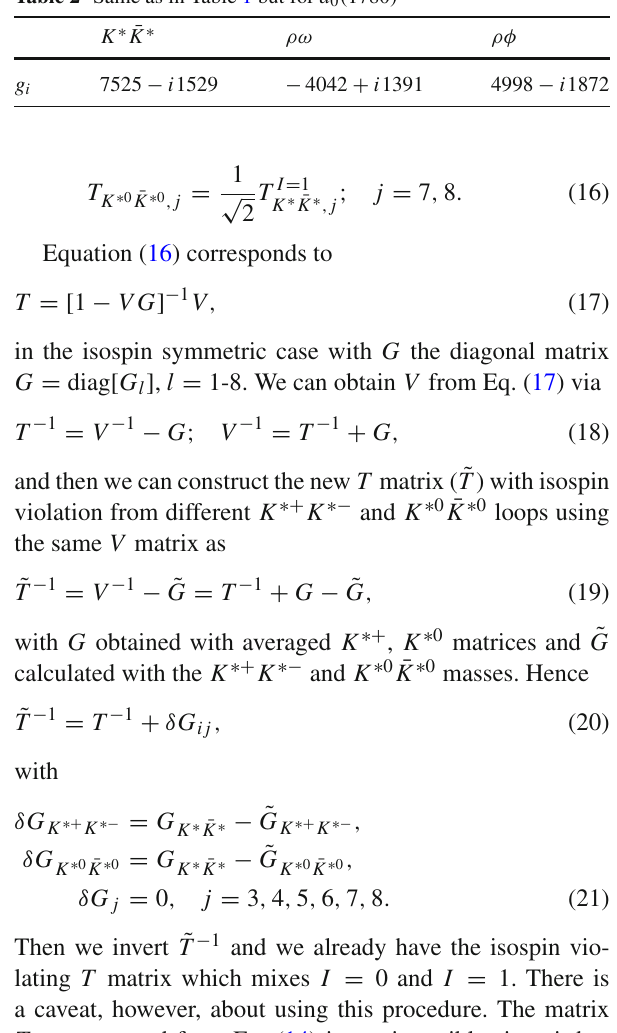
Table 2 Same as in Table 1 but for a 0 ( 1780 )